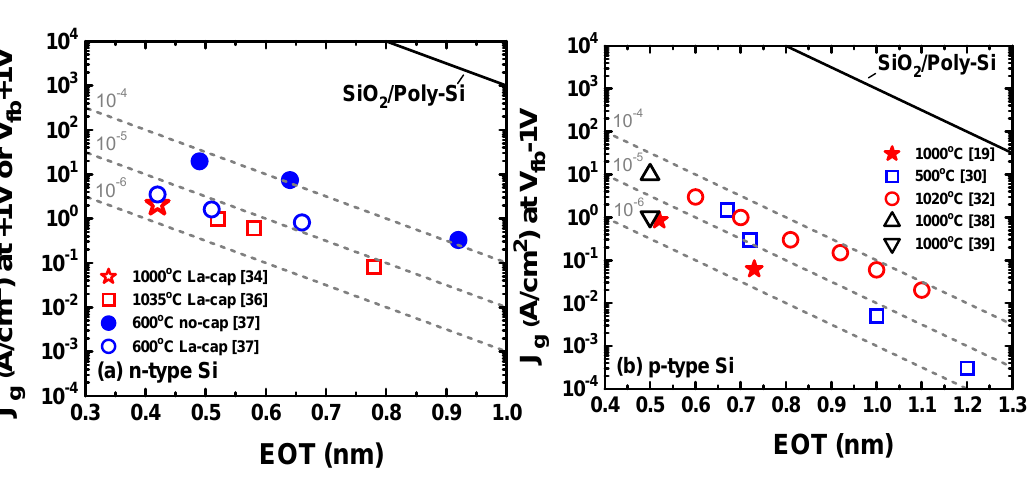
is defined at g = 1 V for [36]; ( b ) EOT-J g g )/HfO gate dielectrics in literature. J 2 2 g scaling are 2 reduction from SiO /Poly-Si stacks in both g 2